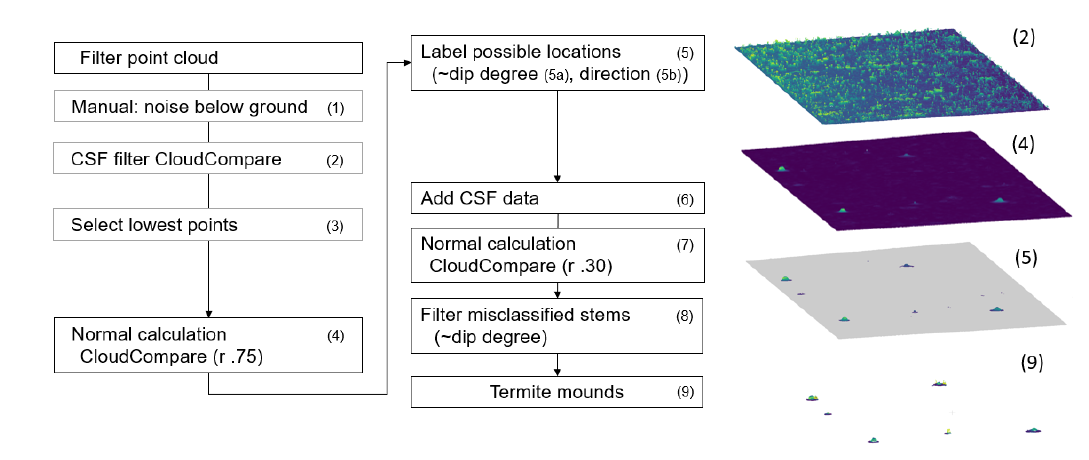
Figure 3. Overview of the main steps to extract termite mounds from UAV-LS data. CSF, cloth simulation filter. Table 2. Overview of the user-adjustable parameters of the termite mound detection algorithm. Step (Figure 3)